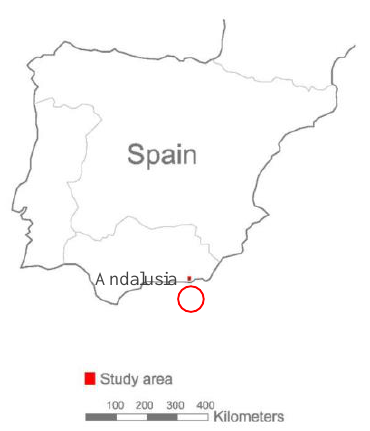
Figure 1 . Location of the study area.